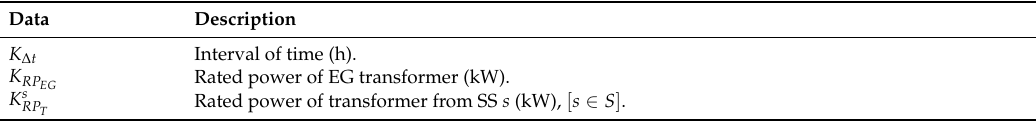
Table 2. Summary of input data (constants).